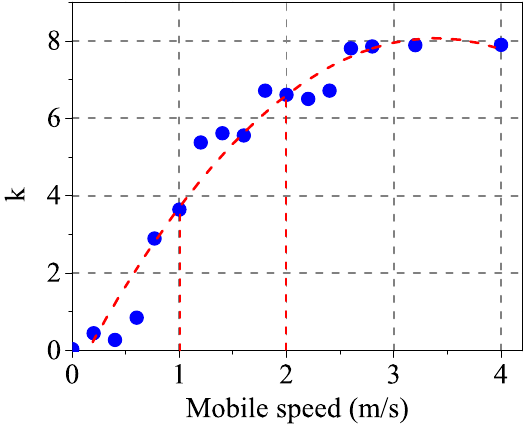
Figure 4. Relationship between k and mobile speed.